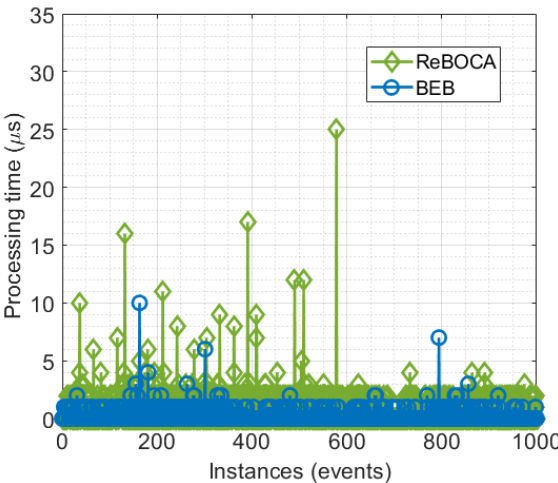
Figure 8. Comparison of computational complexity between our proposed ReBOCA mechanism and the conventional BEB